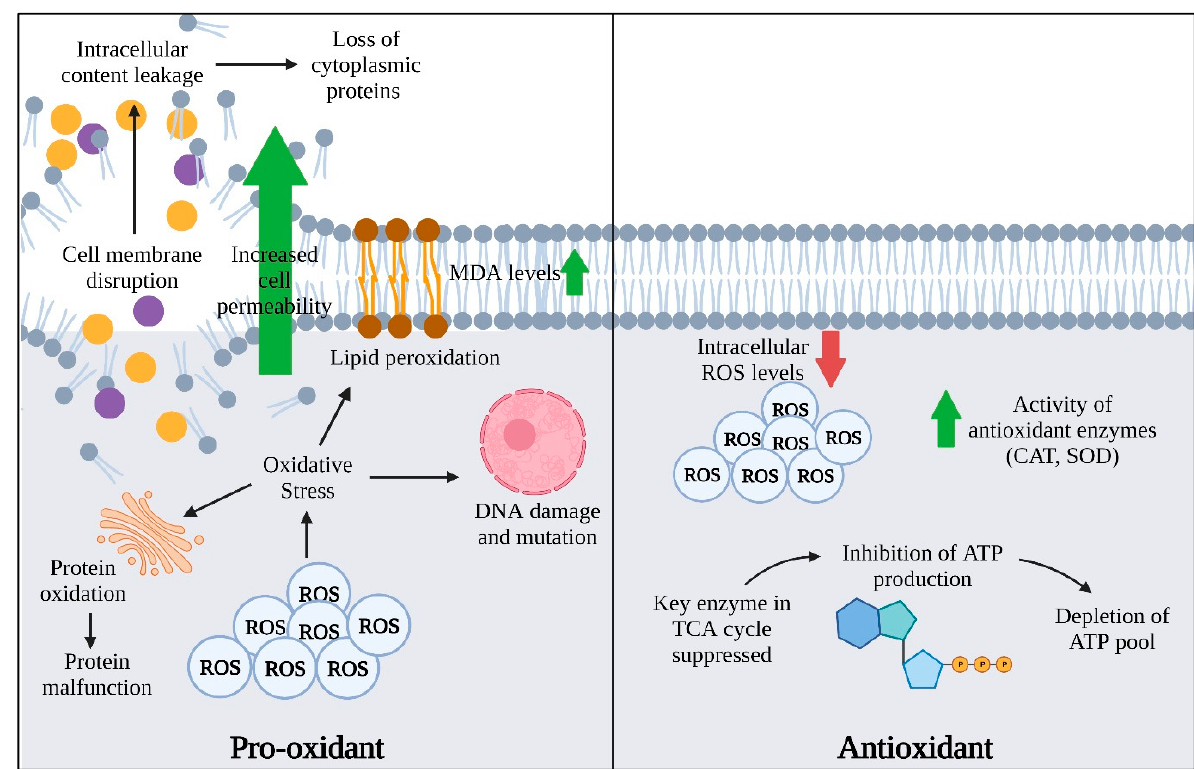
Figure 1. A schematic representation of pro-oxidant and antioxidant activities of EOs against clinically important pathogens. Both pro-oxidant and antioxidant properties of EOs act on different mechanisms of action that eventually lead to bacterial cell death.